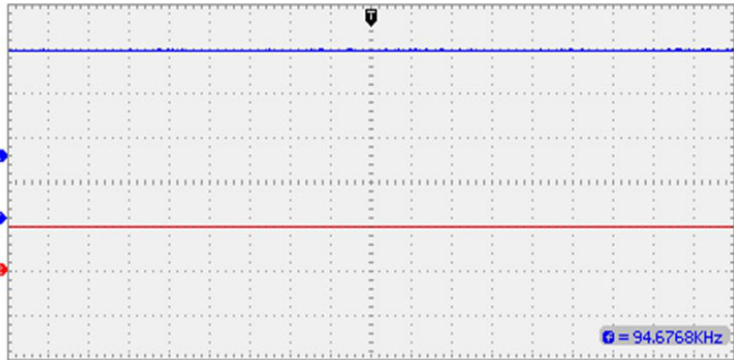
Figure 13. Output voltage ( top ) (vertical scale 300 V/div) and input voltage ( bottom ) (vertical scale 50 V/div).